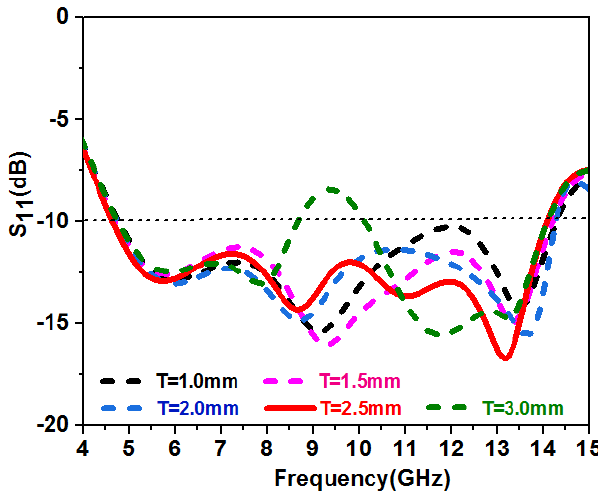
Figure 8. Parametric analysis for variation in T for S11.